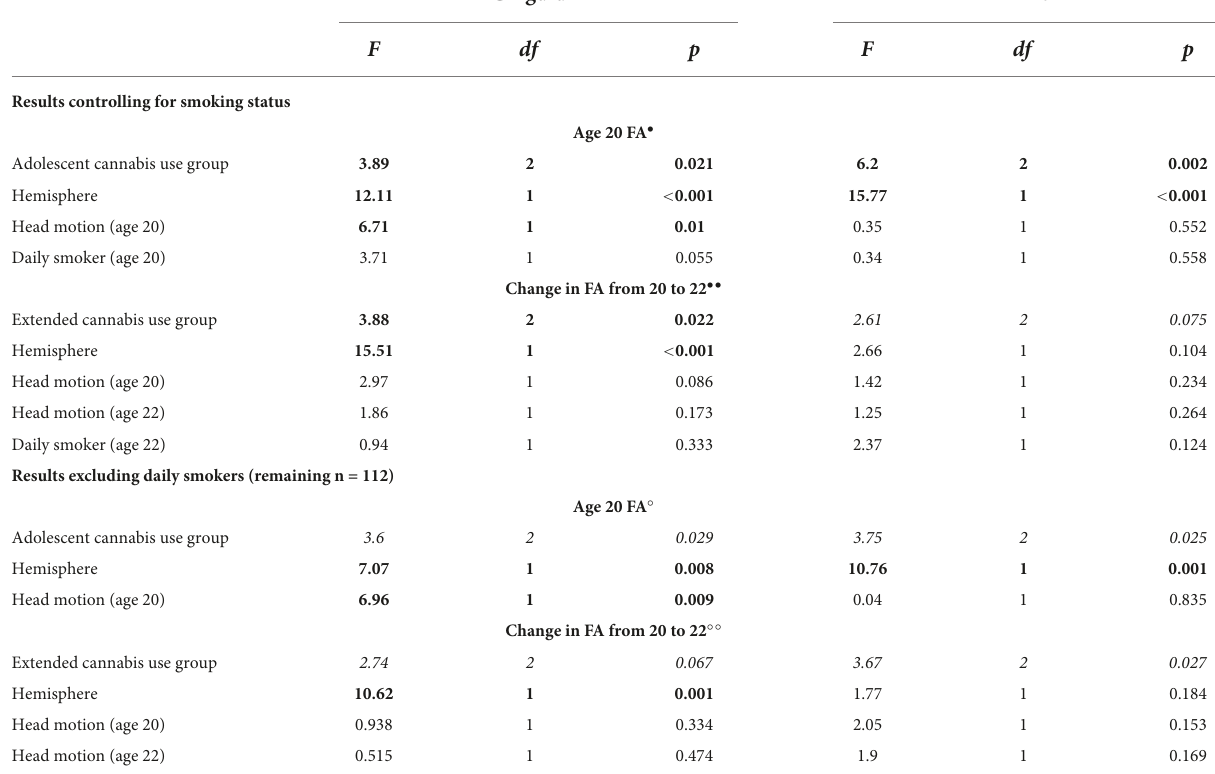
TABLE 5 Sensitivity analyses for smoking